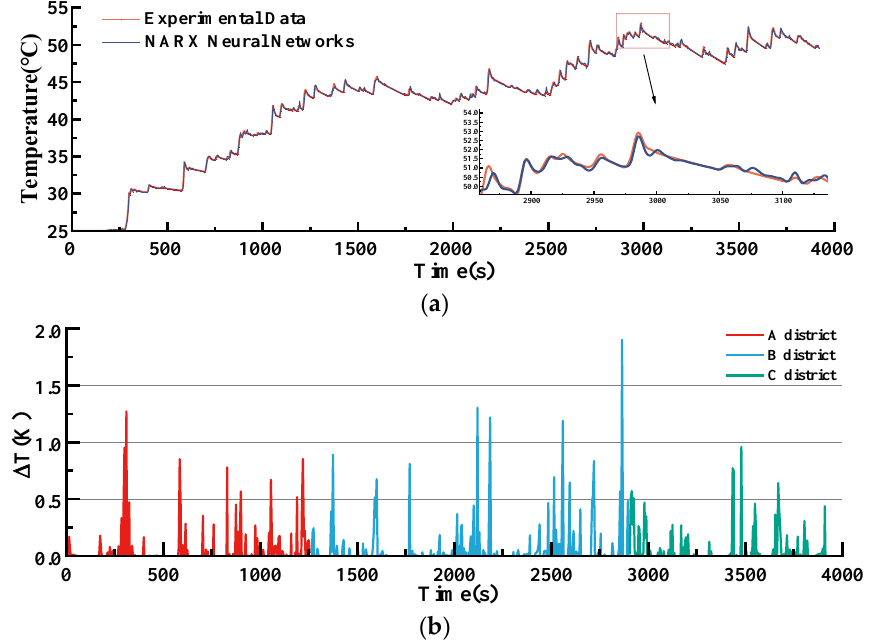
Figure 17. ( a ) Comparison of NARX neural network and actual battery temperature. ( b ) Error.